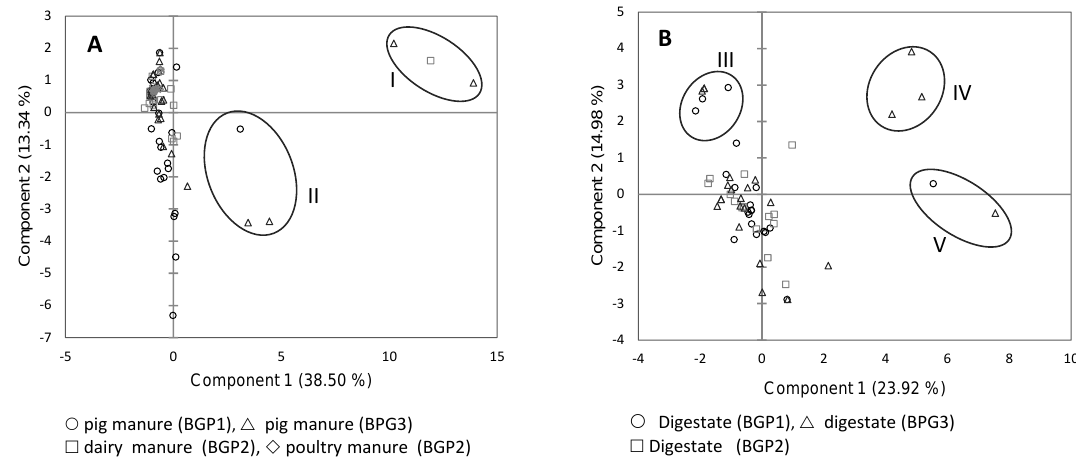
Figure 1. Principal components analysis (PCA) of antimicrobial resistance profiles of C. perfringens isolates from manure ( A ) and digestate ( B ) in three BGPs. Groups I to V contained highly resistant isolates. Table 5. Minimum inhibitory concentration (MIC) distribution ( µ g / mL) of 13 antimicrobials tested against 138 isolates of C. perfringens originating from three